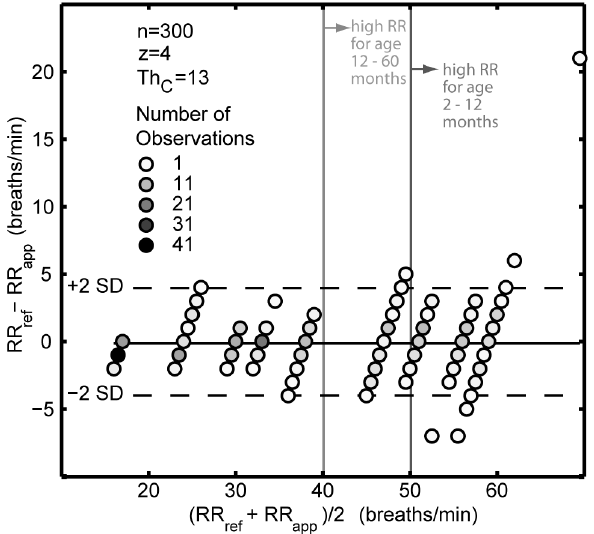
Figure 10. Bland-Altman plot of the optimal parameter configuration (z=4, Th C =13) for the RRate application, deter- mined by data from Phase I and II (n=300). The mean difference (bias) is 2 0.13 breaths/min and the standard deviation (SD) is 1.98 breaths/min. The number of observations is displayed as marker intensity. The dashed lines represent the 95 th percentile range. The vertical lines correspond to the limits for fast breathing by age [1].